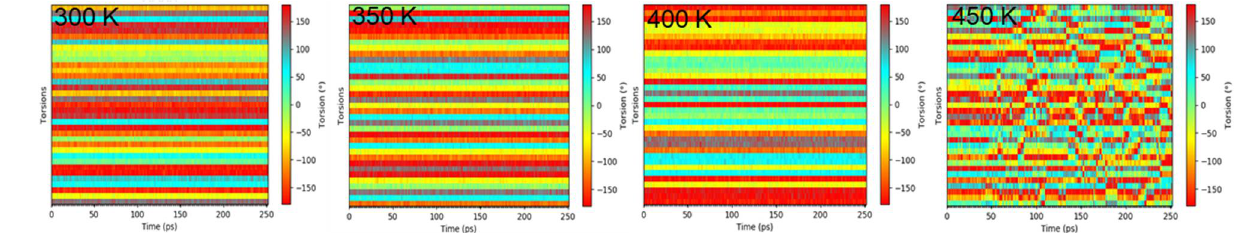
Figure 9. Display of angles for each individual torsion as a bar plot for the simulation of a time range with colors denoting the size of the angle for BADCy.